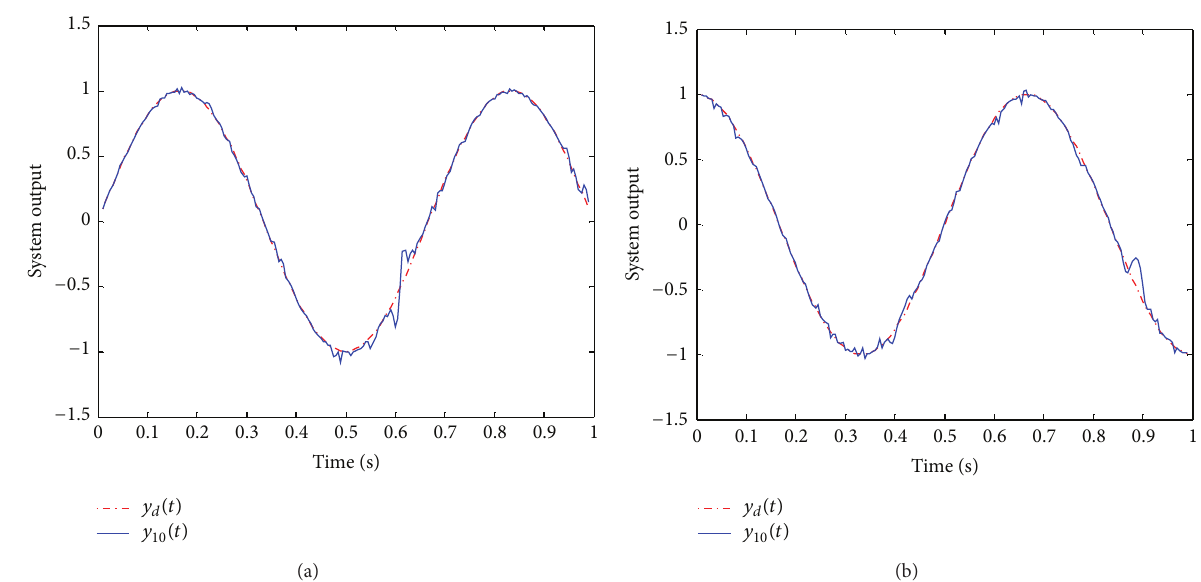
Figure 8: System output trajectory at 10th iteration for Example 2: (a) 𝑦 1,𝑘 (𝑡) , (b) 𝑦 2,𝑘 (𝑡)